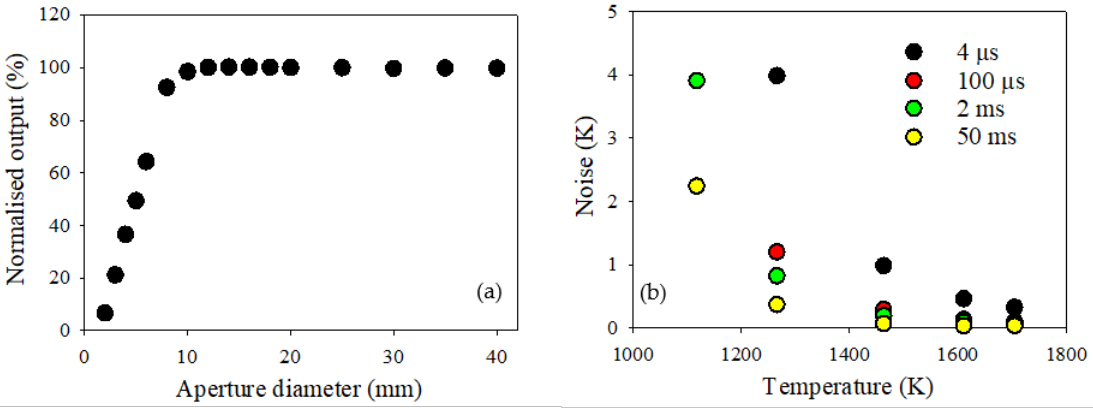
Figure 6. ( a ) FOV and SSE for the IRT and ( b ) RMS noise as a function of target temperature for integration times of 4 µ s, 100 µ s, 2 ms and 50